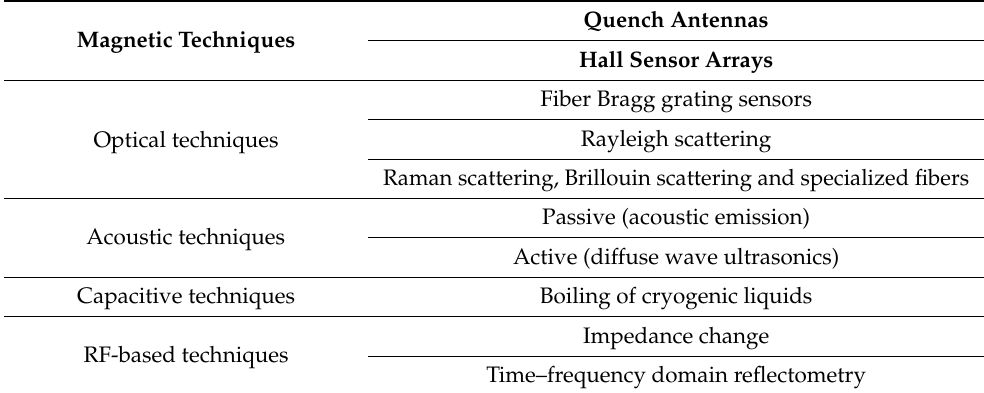
Table 1. A summary of non-voltage quench detection